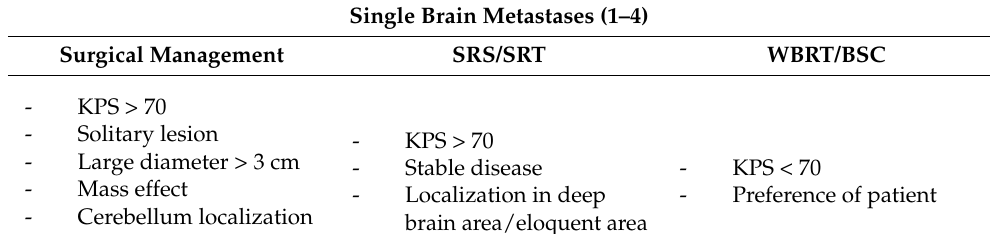
Table 3. Simple treatment algorithm for the approach to a BC patient affected by BM. Single Brain Metastases (1–4)